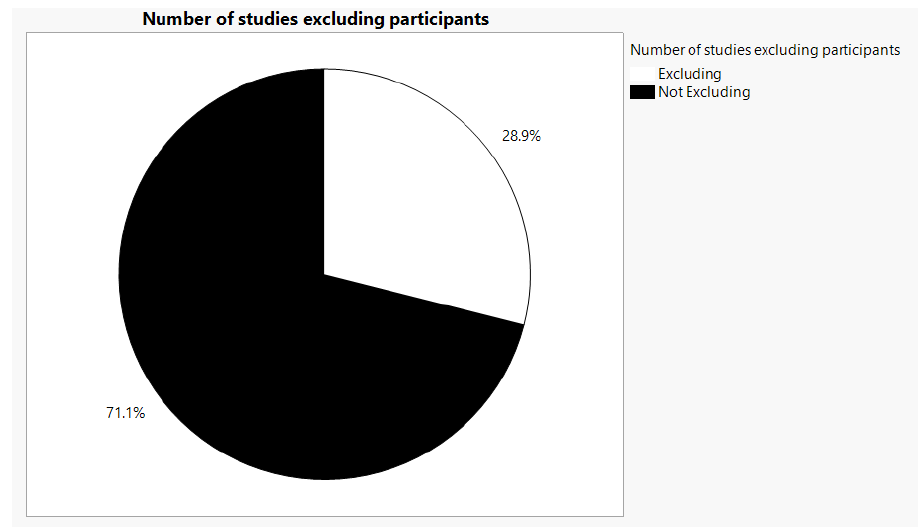
Figure 7. Comparison of studies excluding participants across the 38 studies related to AFEA, beverages, and/or packaging.